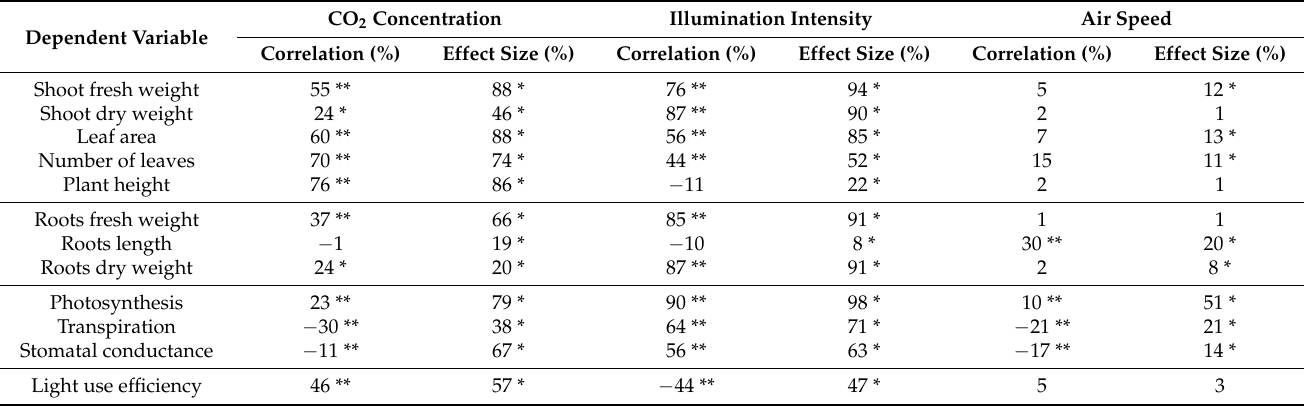
Table 1. Correlation and effect size of CO 2 concentration, illumination intensity and air speed on the growth, gas exchange and light use efficiency of lettuce plants grown under artificial lighting.